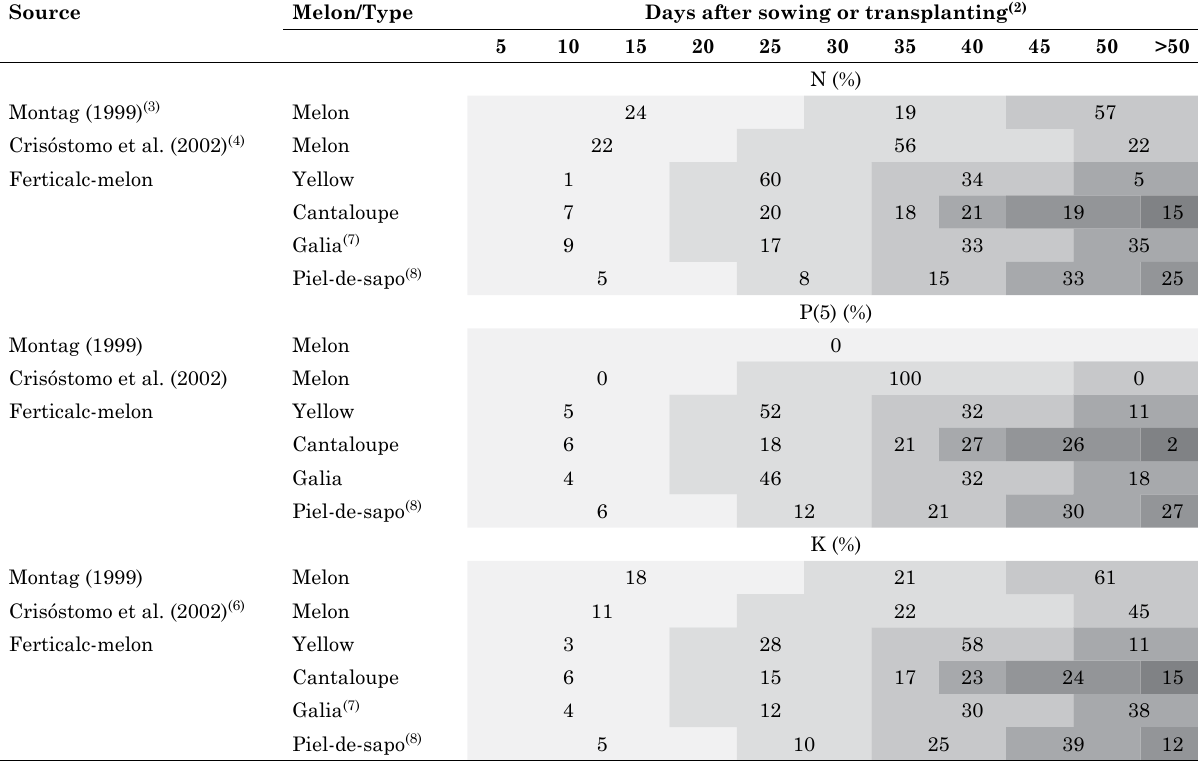
Table 7. Ferticalc-melon recommendations for relative distribution of nitrogen, phosphorus and potassium nutrients in topdressing (fertigation)